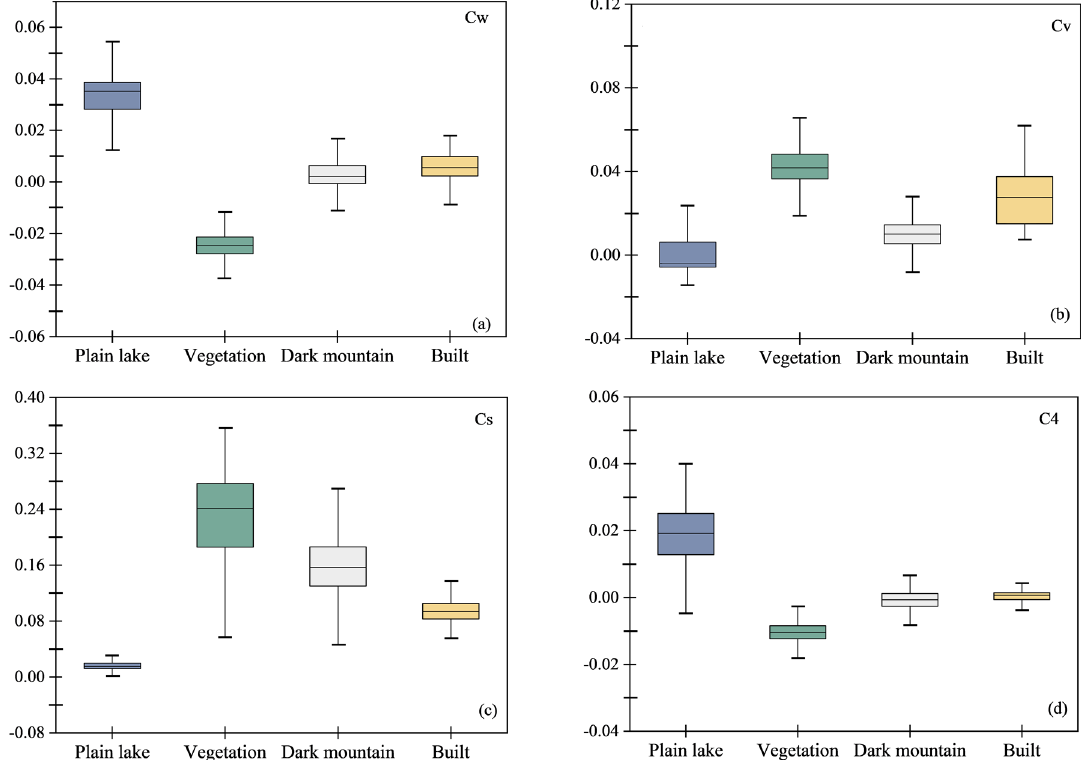
Figure 4. The UPDM dimensional space distributions of pure pixels of major land cover types based on MODIS images, ( a ) C w , ( b ) C s , ( c ) C v , and ( d ) C 4 . Each box-plot shows the location of the maximum, 75th, 50th, 25th percentiles, and the minimum values using horizontal lines. ( note, C w , C v , C s , and C 4 are the decomposition coefficients for water, vegetation, soil, and yellow leaves, respectively )